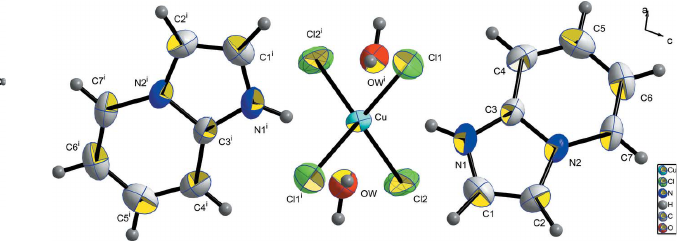
Figure 1 ORTEP -style plot of the structural unit with displacement ellipsoids at the 50% probability level. [Symmetry code: (i) 1 (cid:3) x , y , 1